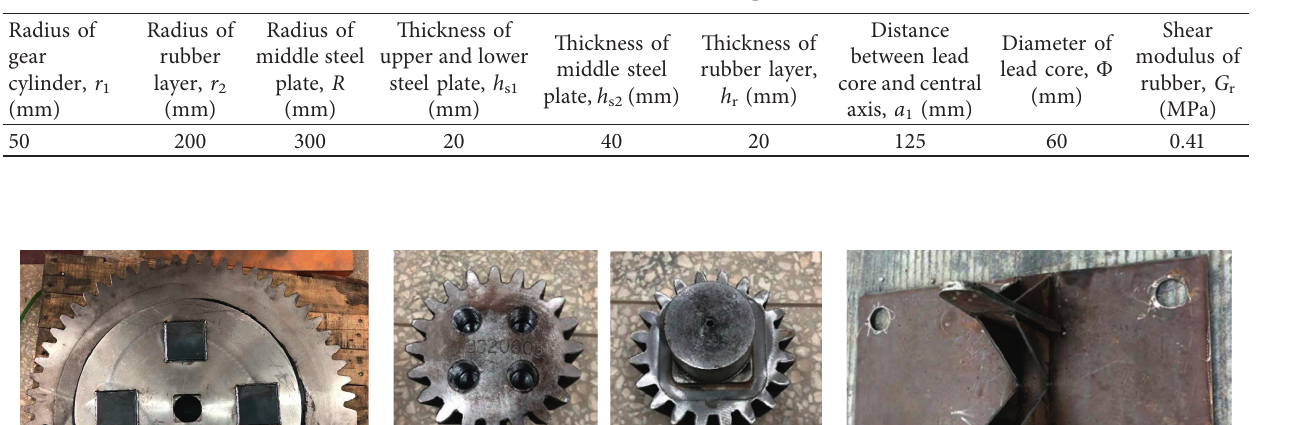
Table 2: Parameters of the DATD specimen.